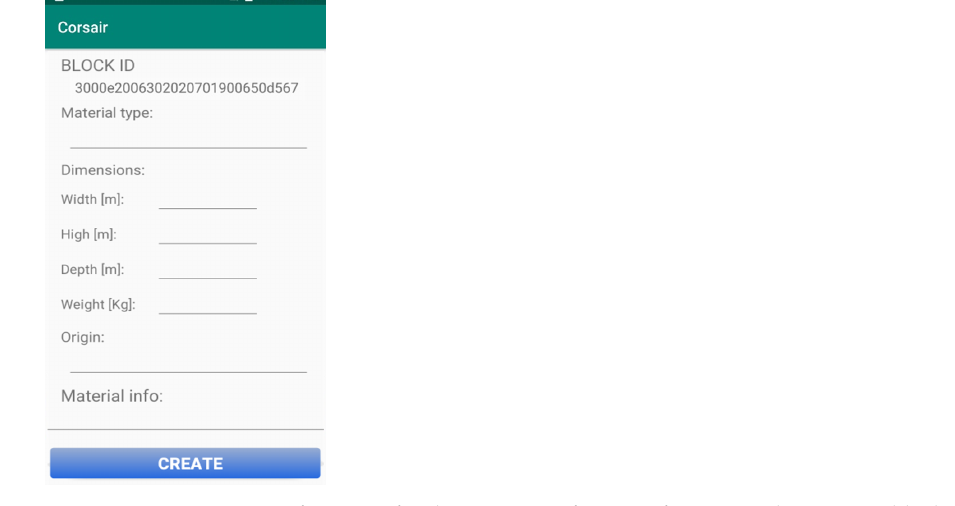
Figure 9. CORSAIR App fragment for the insertion of some information about a new block.